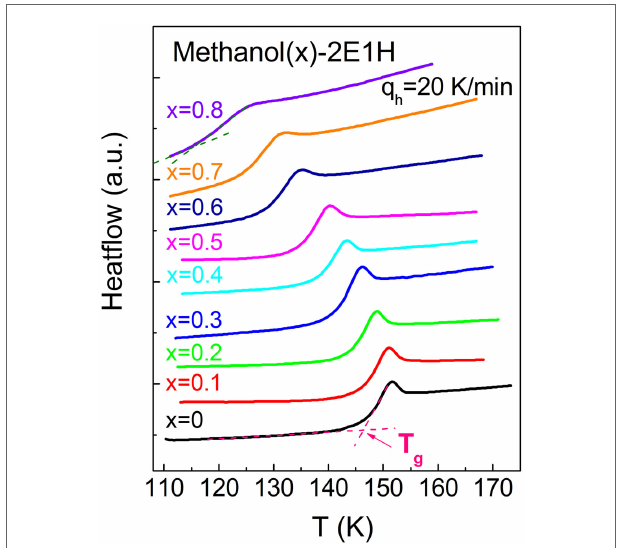
FigUre 6 | glass transition heat capacity curves measured at the heating rate of 20 K/min for the methanol – 2-ethyl-1-haxanol (2e1h) mixtures quenched at the same cooling rate . The calorimetric glass transition temperature, T g–cal , is defined. x is the mole fraction of